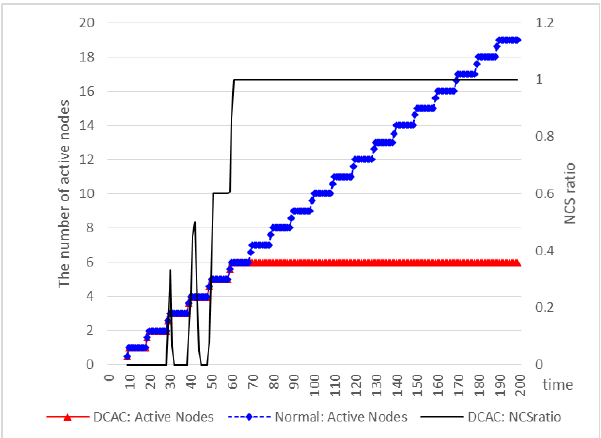
Figure 1. The number of active nodes in DCAC and normal DESYNC according to the NCS